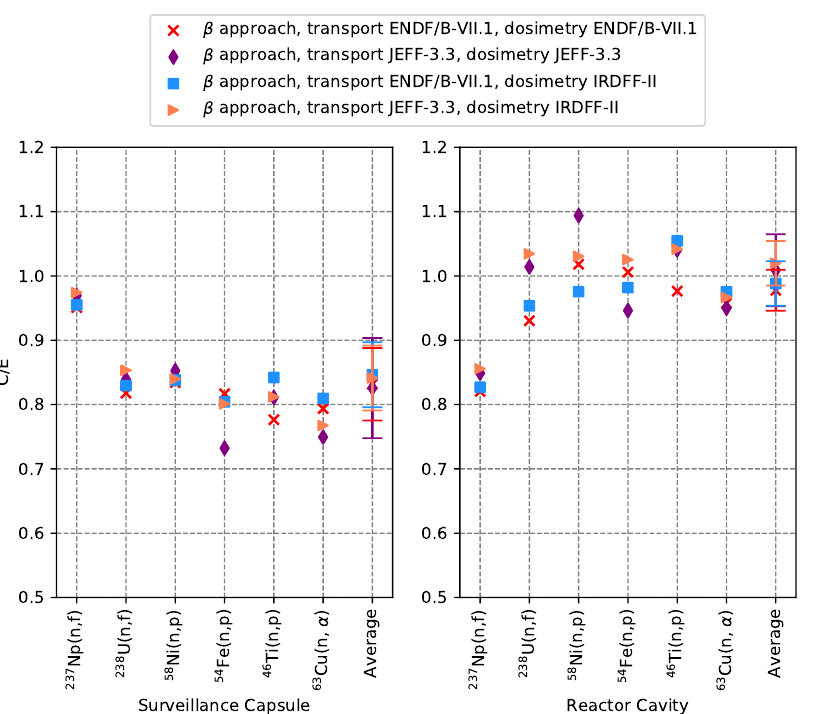
Figure 11. The C/E ratios obtained with the β approach and various combinations of nuclear data libraries. The 237 Np(n,f) specific activity is not taken into account in the calculation of the average C/E value in the